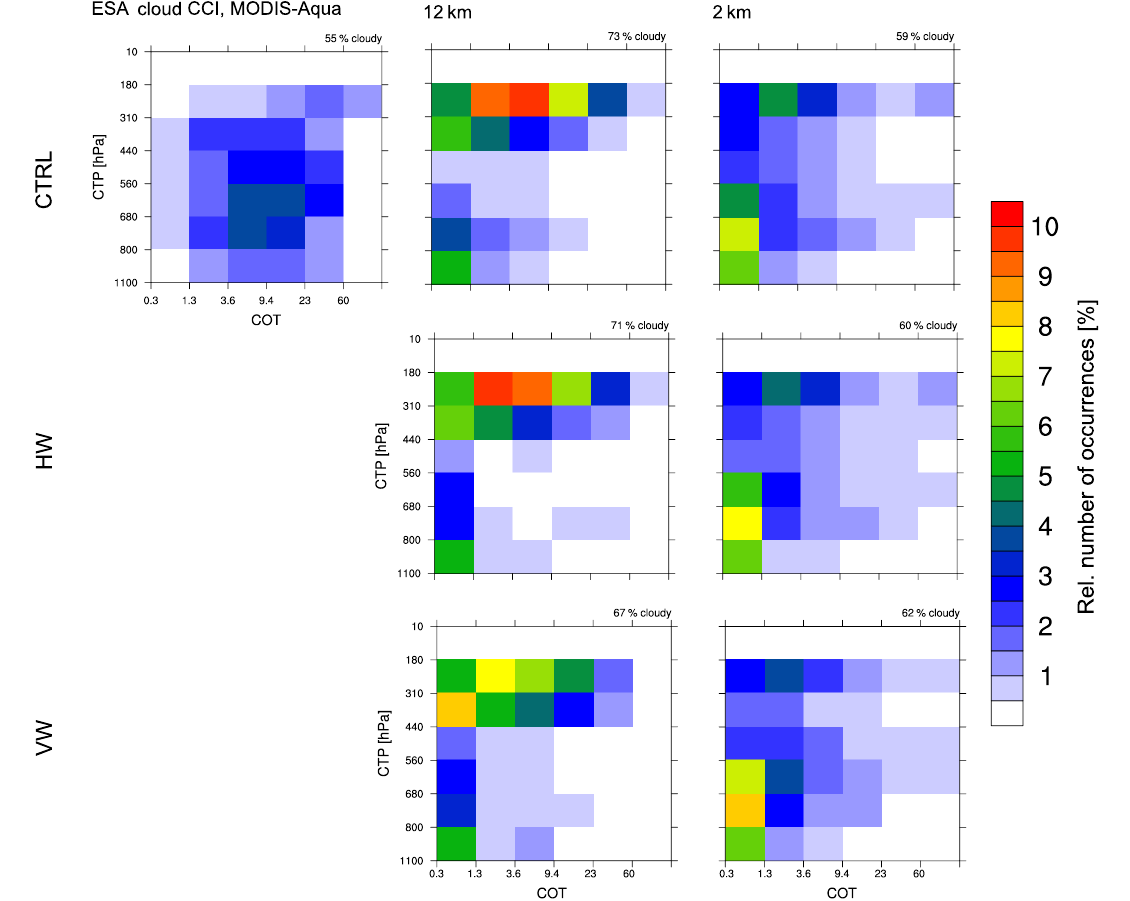
Figure 6. Histograms of cloud frequency as a function of COT and CTP arranged as in Fig. 3 but showing averages at 13:00UTC (for each model) over the period of 3–13 June 2007. For the observations, the average is taken the time of the Aqua satellite passage (approximately 13:30UTC). Fractional cloud cover is indicated in the right upper corner of all panels. Cloud-free conditions are assumed for a cloud optical thickness below